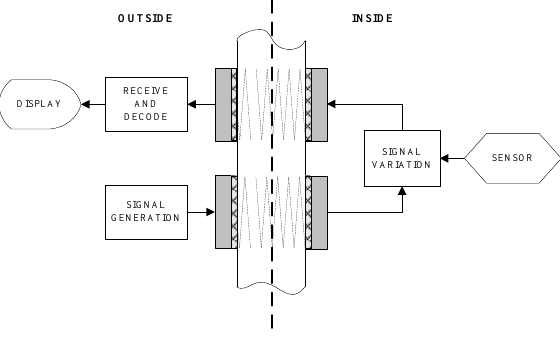
Figure 7. Diagram of two pairs of PZTs configuration, redrawn from Murphy [55].